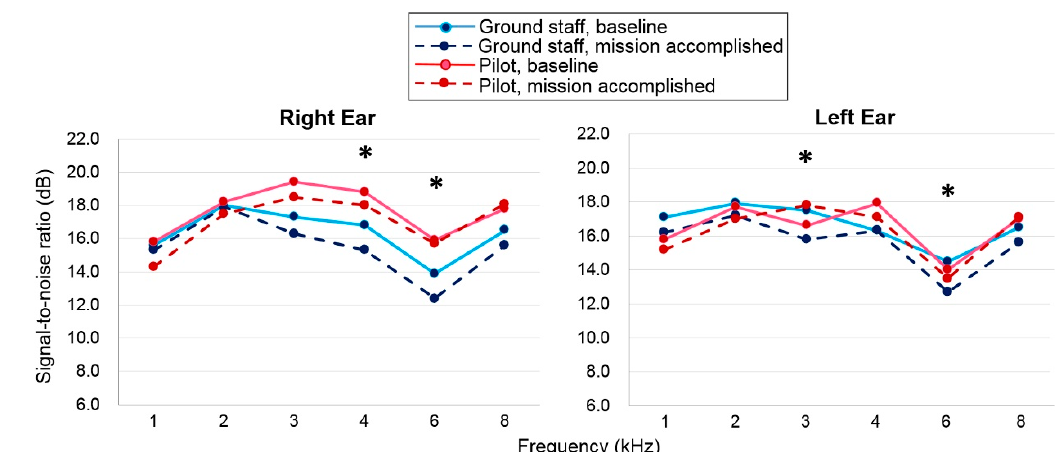
Figure 5. Mean of the signal-to-noise ratio of distortion-product otoacoustic emissions (DPOAEs) for both ears between the ground staff and pilot groups before and after a flight mission execution. * indicates p < 0.05, comparing the ground staff group before and after the flight mission noise exposure.